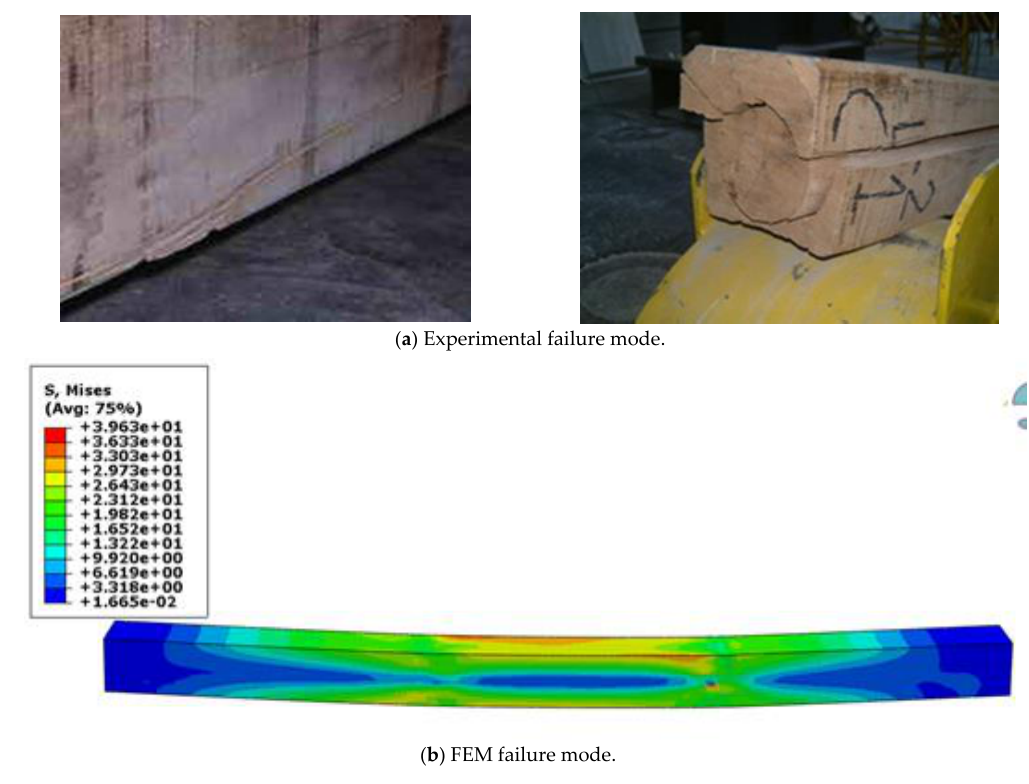
Figure 13. Comparison of failure modes between FEM and experimental test of unreinforced timber beam (stress values are in MPa).